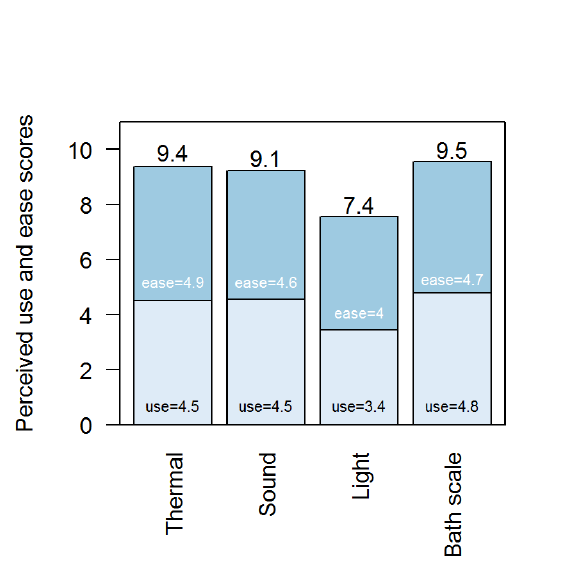
Figure 2. Means scores of perceived usefulness & ease of use depending on the sensor